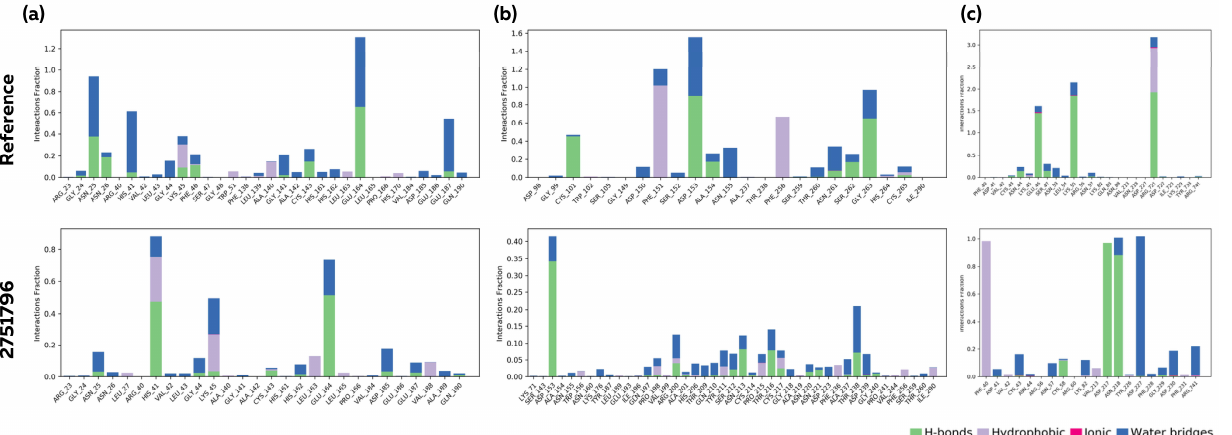
Figure 7. The protein–ligand interaction diagram illustrating the fraction of amino acids interacting with the ligands monitored over the 100 ns MD simulation. Analysis of protein–ligand interaction for ( a ) Ligand–Mpro, ( b ) Ligand–PLpro, and ( c ) Ligand–RdRp complexes. The protein–ligand interactions are illustrated as hydrogen bonds, hydrophobic, ionic, and water bridges. The stacked bar charts are normalized over the course of the trajectory.